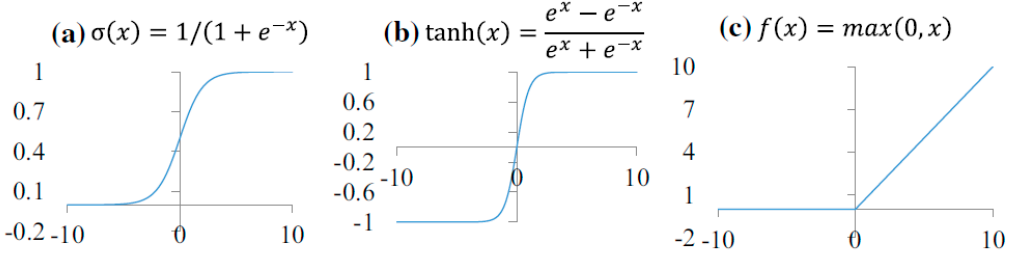
Figure 8. Activation function. ( a ) Sigmoid, ( b ) tanh, ( c ) ReLU.